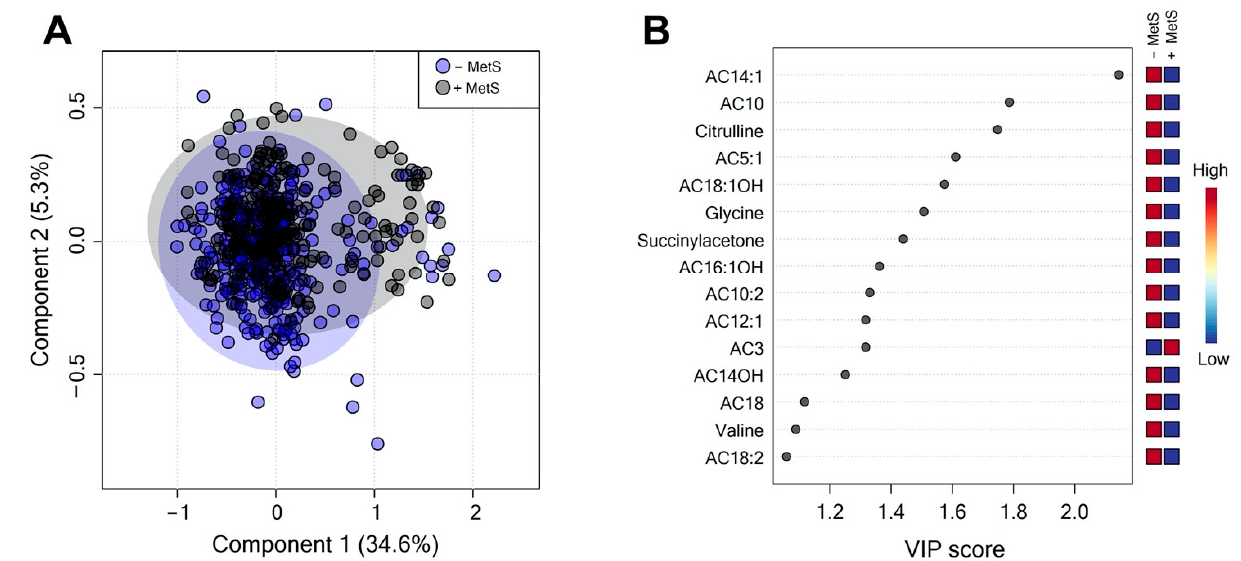
Figure 2. Serum metabolic profile according to MetS status. ( A ) PLS-DA plot shows differences between groups; − MetS (gray circles), +MetS (purple circles). The explained variances are shown in brackets (accuracy 0.63; R2 0.096; Q2 0.027: permutation p value < 5.0). ( B ) VIP analysis represents the relative contribution of metabolites to the variance among groups. A high VIP score represent a greater influence of the metabolites to the group separation. Red and blue boxes on the right, indicate whether metabolite concentration is increased (red) or decreased (blue). − Mets (without MetS), +MetS (with MetS).